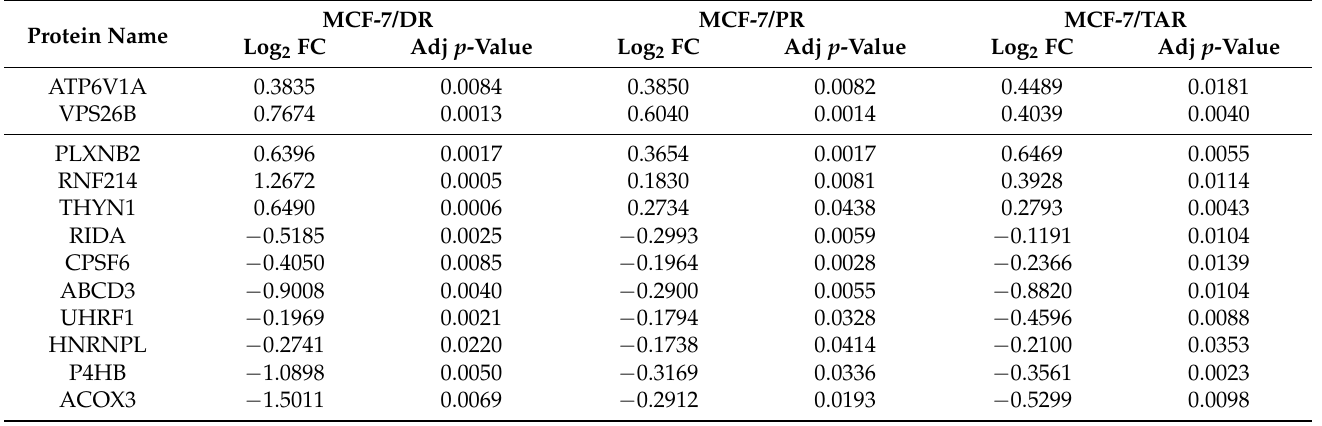
Table 2. Summary of 12 prognostic marker candidates. The Log 2 FC was calculated between parental MCF-7 and drug-resistant cells using TMT 6-plex